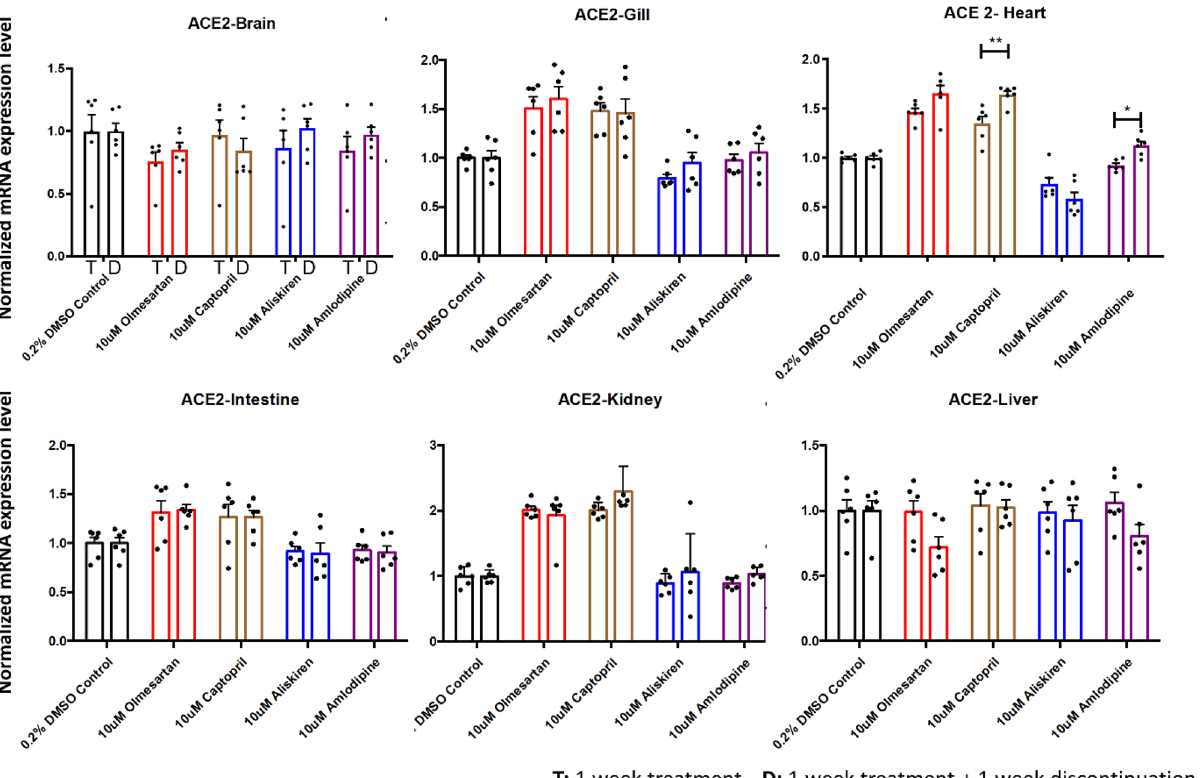
Figure 5. Comparison of ace2 expression levels between treatment and discontinuation. The expression levels were compaired between the 1-week treatment group and 1-week treatment plus 1-week discontinuation group for different organs. The captopril and amlodipine treatment increased ace2 mRNA expression in the heart 7 days after discontinuation compared to 7-day treatment (n = 6 per group; * p < 0.05, ** p < 0.01, unpaired t